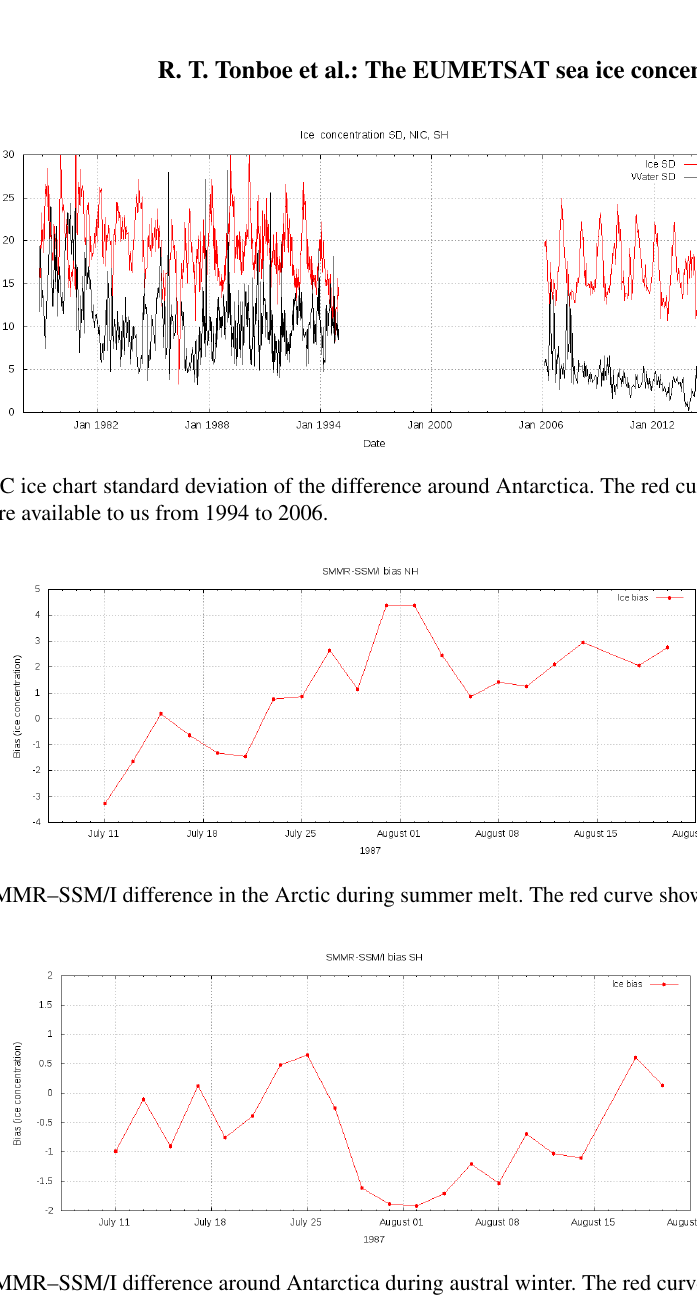
their signatures and the two instruments’ different orbits and data